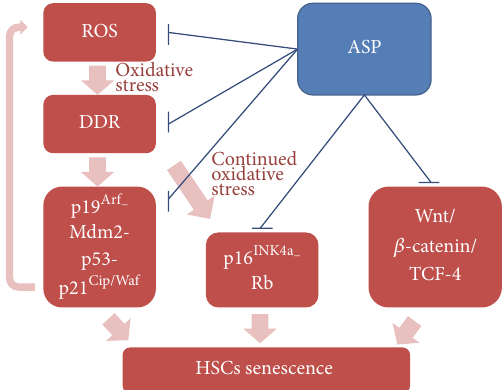
Figure 6: The summary of the effects of ASP on HSCs